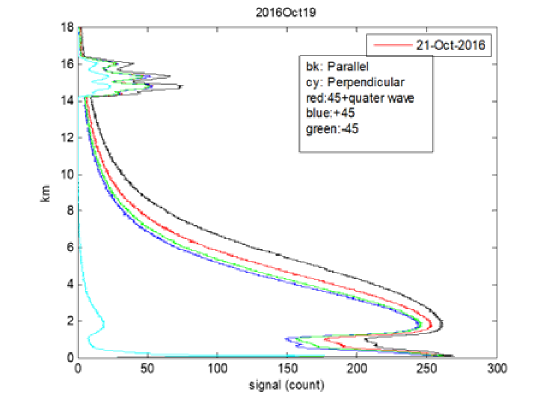
Fig. 2 Backscattering signals measured by various linear polarizers.